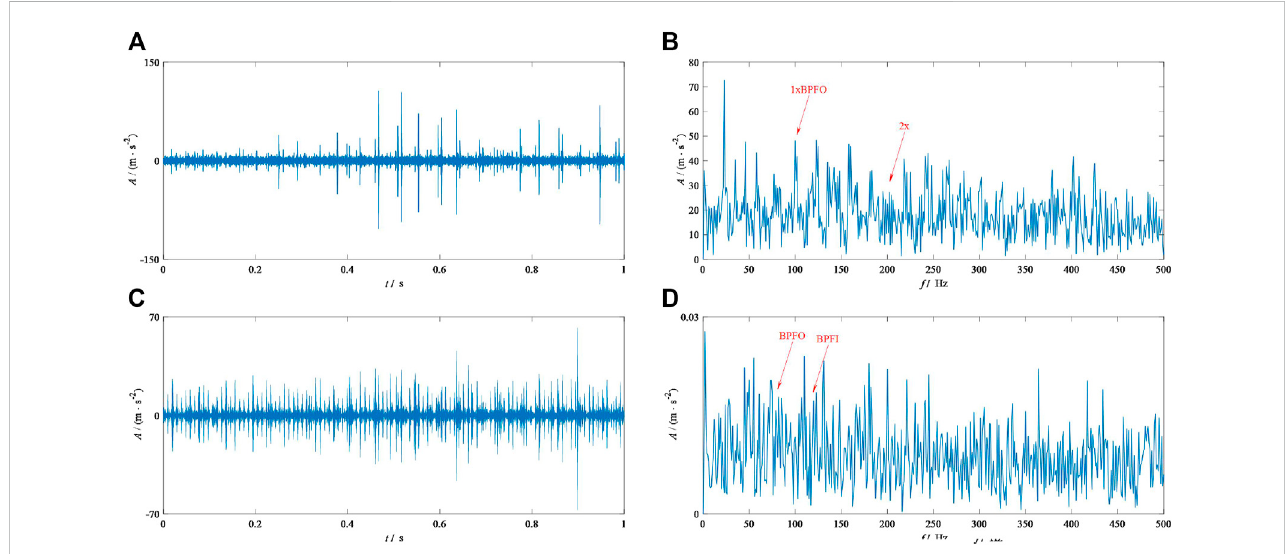
FIGURE 14 Results from signal CU-O: (A) ICF-VMD TDW, (B) ICF-VMD SES, (C) IEFI – VMD TDW, and (D) IEFI – VMD SES.